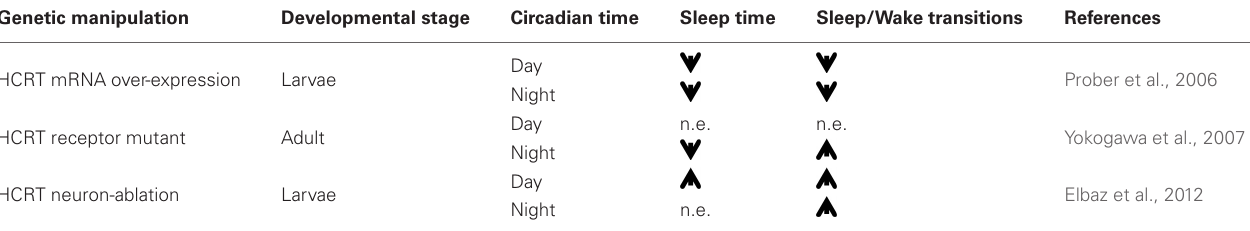
Table 1 | HCRT neurons control behavioral sleep-wake transitions. Genetic